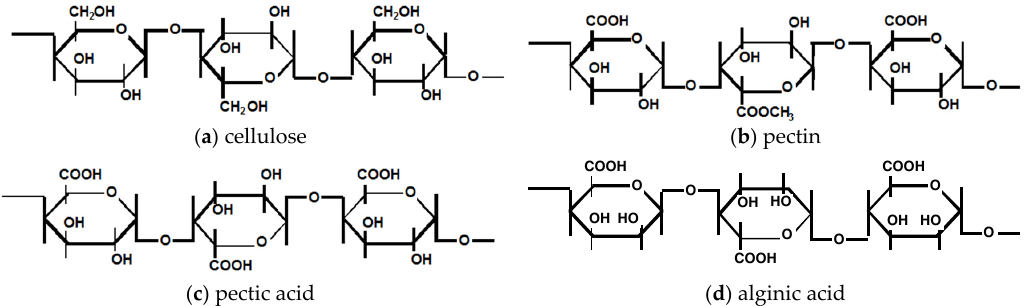
Scheme 5. Chemical structures of cellulose, pectin, pectic acid and alginic acid.